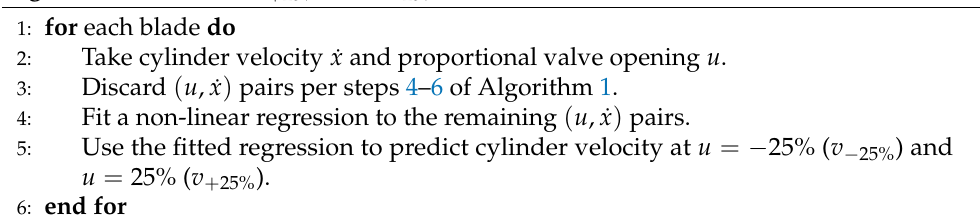
Algorithm 2 Calculate v + 25% and v − 25% from a 10 min